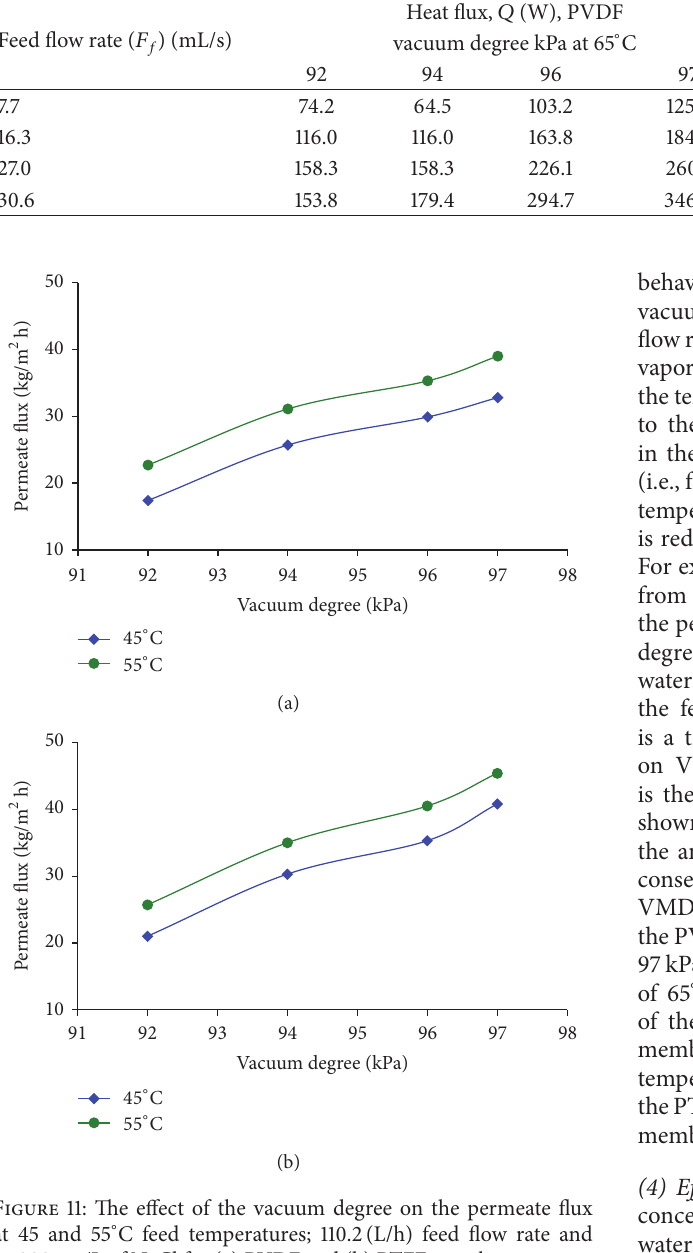
Table 5: Heat flux for evaporation at different vacuum degrees for the PVDF and PTFE membranes. Feed flow rate ( 𝐹 𝑓 ) (mL/s)